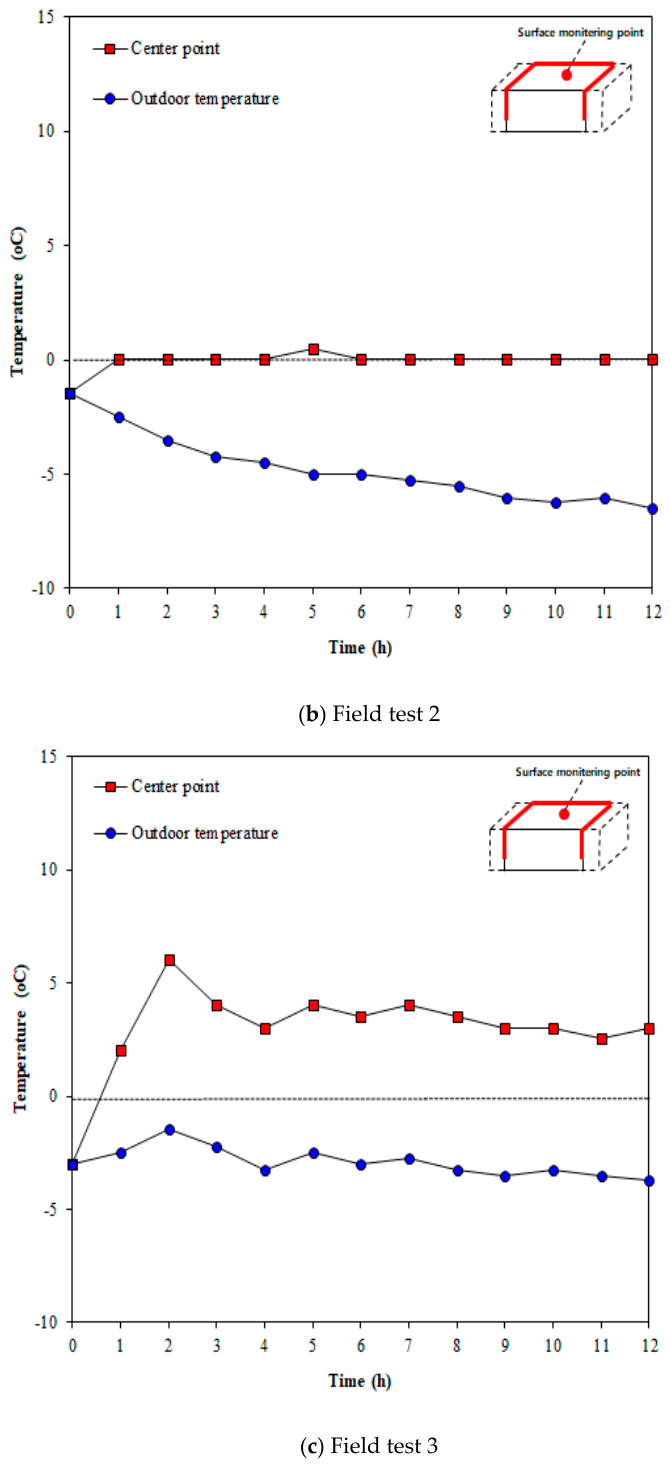
Figure 14. Temperature at center vs. outdoor temperature (Line 1).